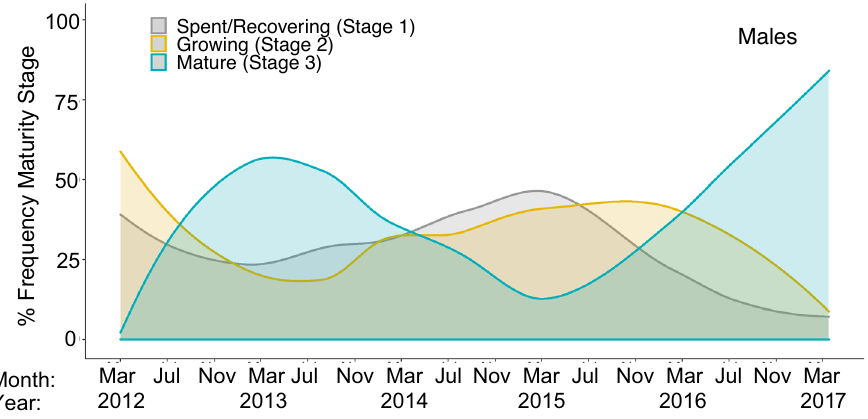
Figure 6. Long-term changes in the percentage frequency (%), represented as a density plot, of maturity stages in the male sample population from March 2012–March 2017. Frequency densities derived from (LOESS) method. The smoothing span was chosen to reflect long-term changes rather than seasonal